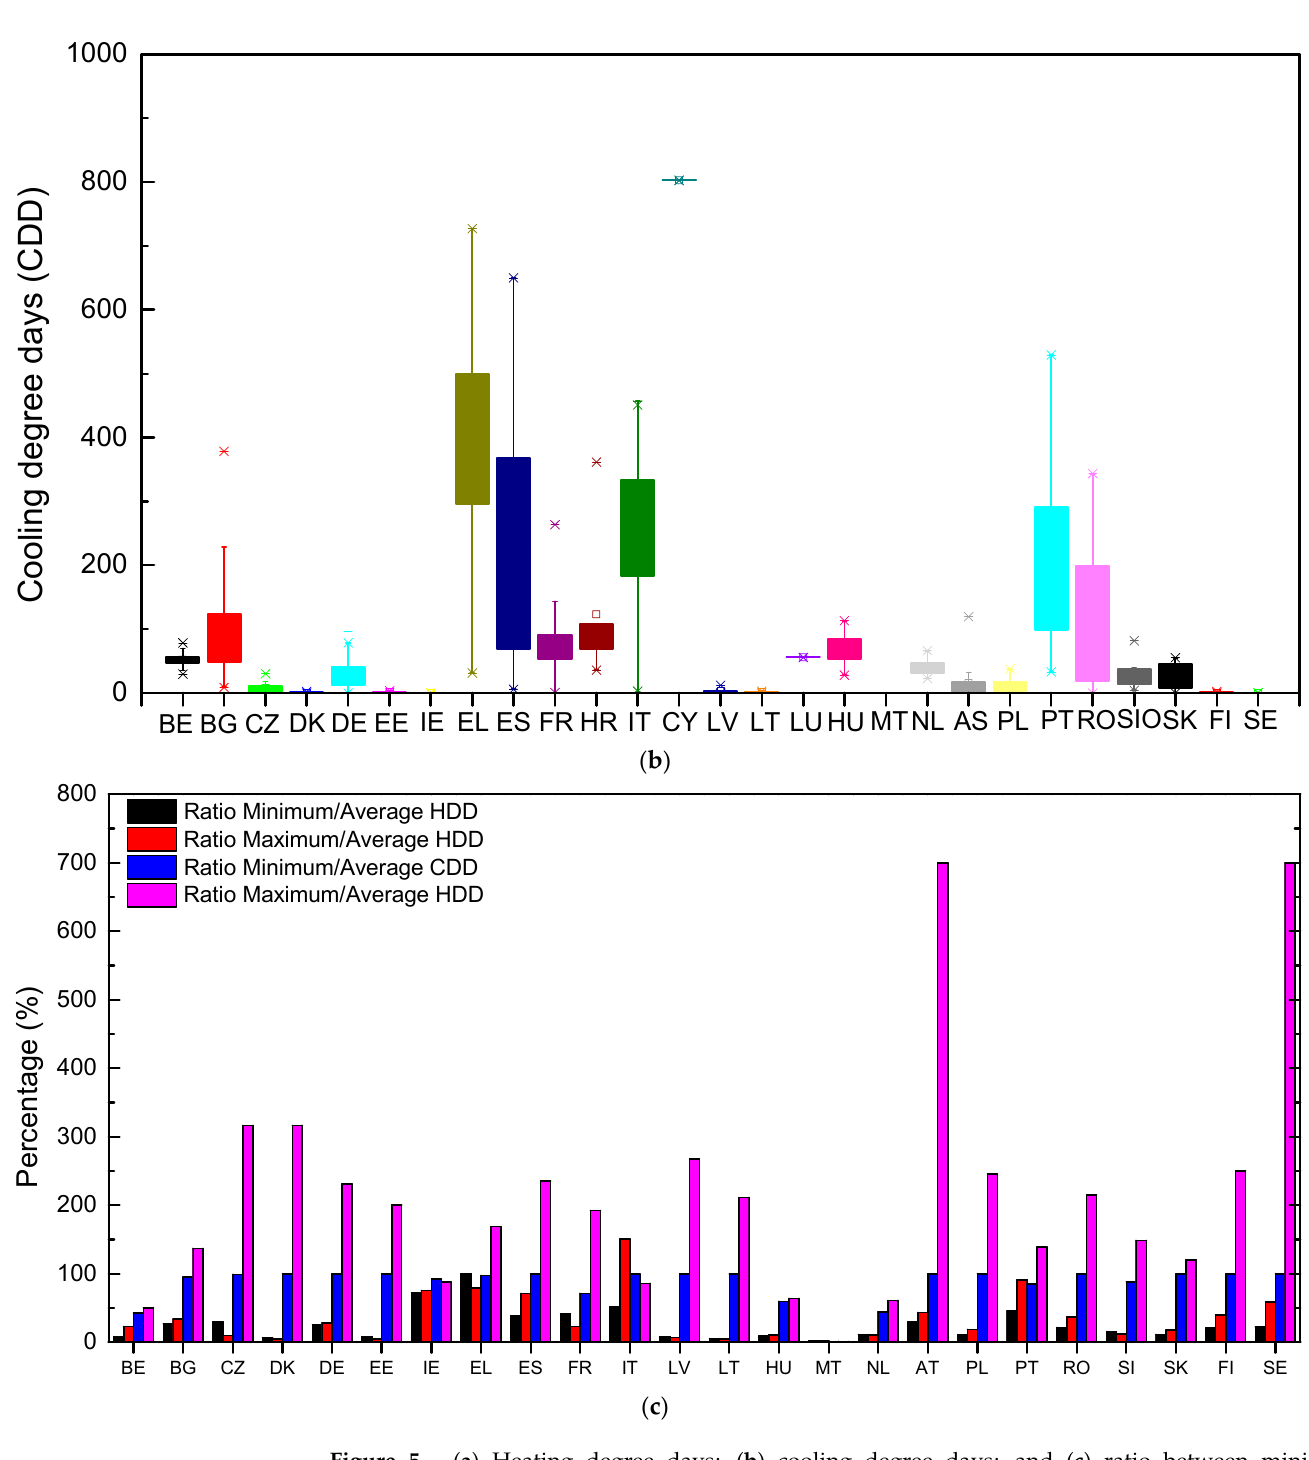
Figure 5. ( a ) Heating degree days; ( b ) cooling degree days; and ( c ) ratio between minimum/maximum HDD and CDD values and the average ones for each country (Sources: EU Buildings Factsheets).